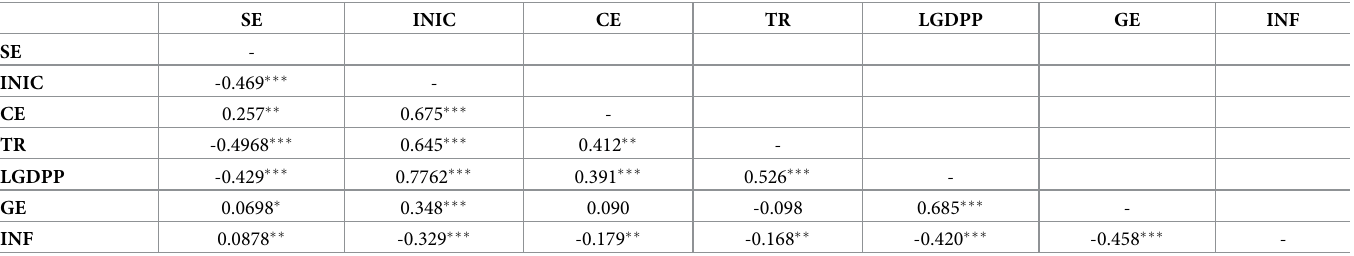
Table 3. The correlation